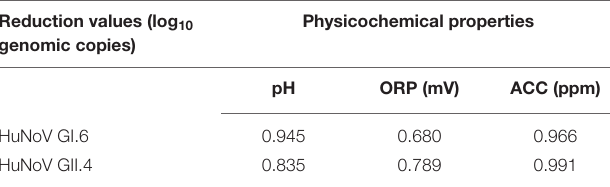
TABLE 2 | Correlation coefficients between reduction value of HuNoVs and the values of pH, ORP, and ACC. Reduction values (log 10 genomic